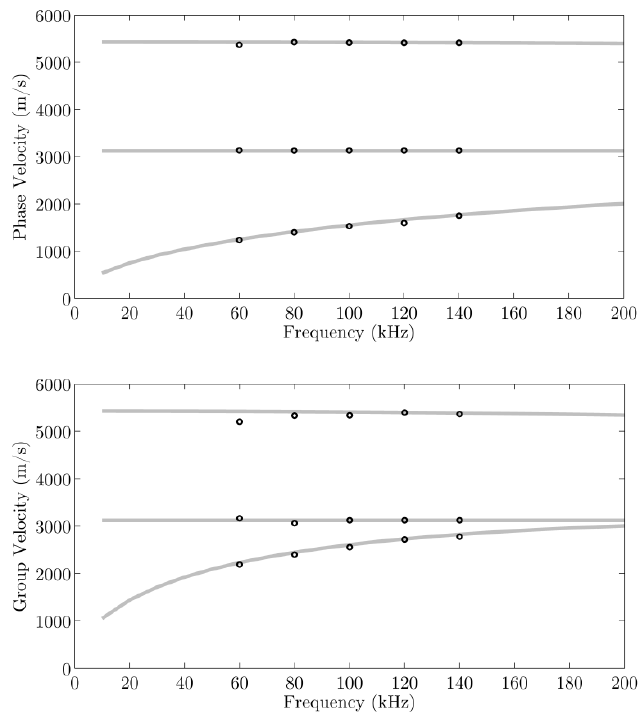
Figure 11. Comparison of the phase velocity and group velocity of S 0 , A 0 and SH 0 between the results from the synthesized signals (black circles) and theoretical values (grey lines).